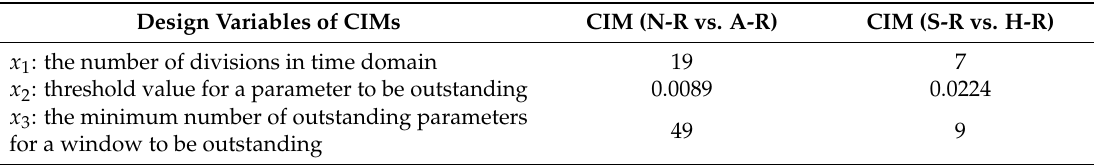
Table 2. Achieved optimal CIMs.